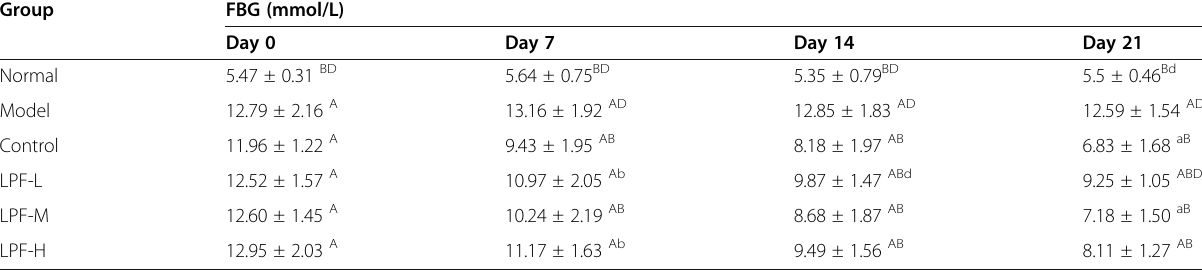
Table 4 Effect of flavonoids from L. plumule on serum glucose of diabetic mice